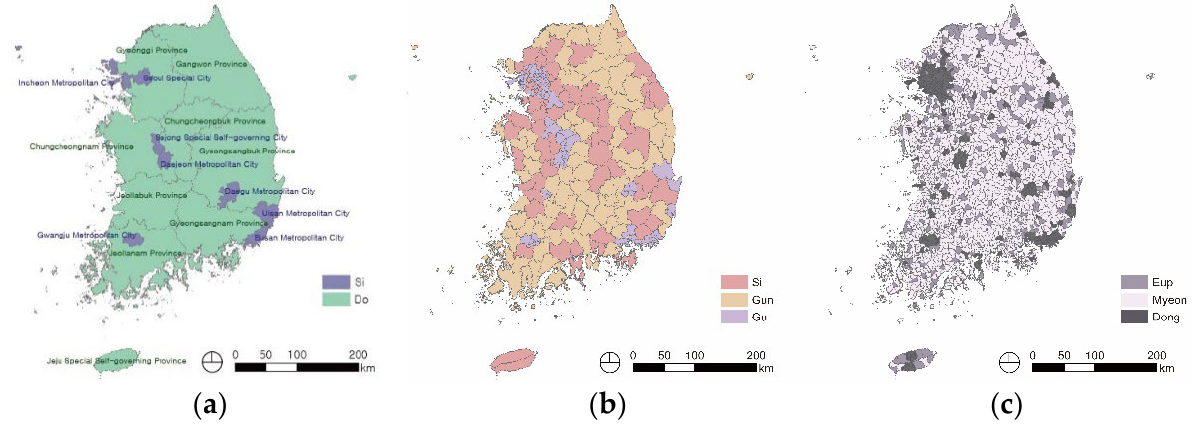
Figure 1. Administrative divisions: ( a ) high level, ( b ) middle-level, and ( c ) low-level. The units of analysis in this study were Eup, Myeon, and Dongs. In 2015, there were 5039 Eup, Myeon, and Dongs in Republic of Korea. Analysis was conducted on 4114 Eup, Myeon, and Dongs, excluding 925 Eup, Myeon, and Dongs, where the Health Interview Survey was not